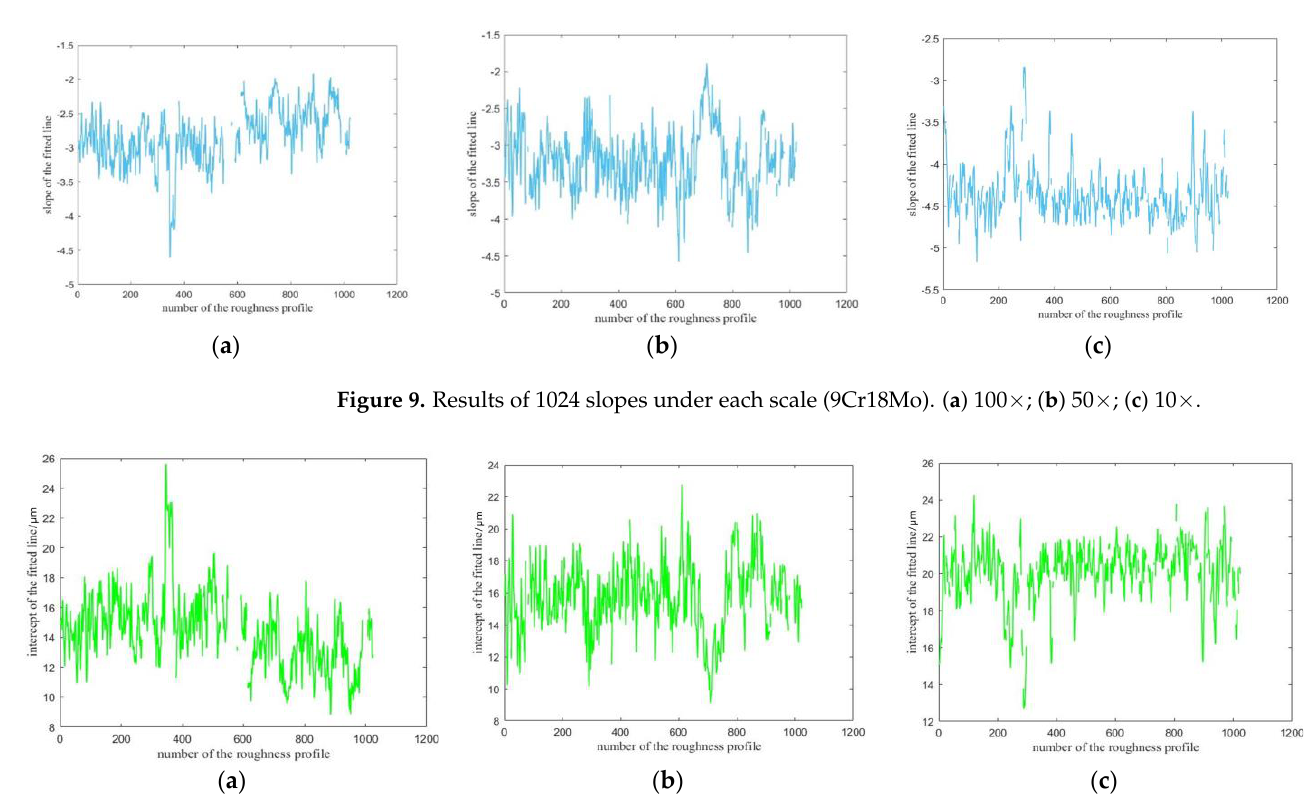
Figure 10. Results of 1024 intercepts under each scale (9Cr18Mo). ( a ) 100 × ; ( b ) 50 × ; ( c ) 10 × . Table 6. Average slopes and intercepts under different measurement frequencies (9Cr18Mo).